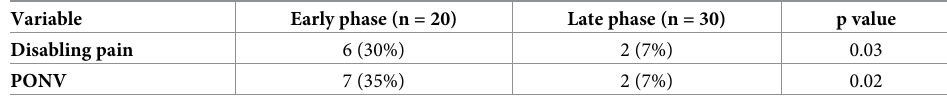
Table 5. Incidence of pain and PONV in the early vs. late phase of ERAS program.